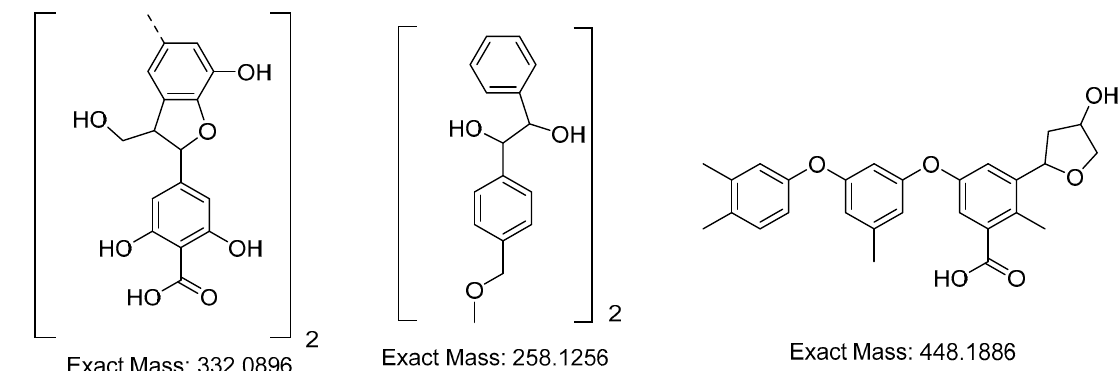
Figure 3. Structure of lignin fragments extracted during the cellulose (pulp) production from miscanthus biomass by hydrotropic delignification in the presence of sodium hydroxide.